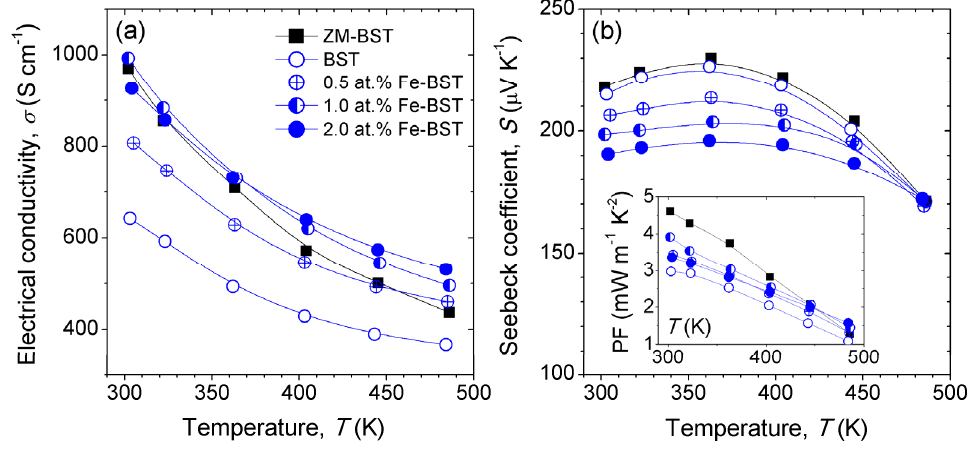
Figure 3. Temperature dependence of ( a ) the electrical conductivity ( σ ) and ( b ) the Seebeck coefficient ( S ) of ZM-BST, BST, and Fe-BTS samples. Inset shows the power factor ( σ · S 2 )